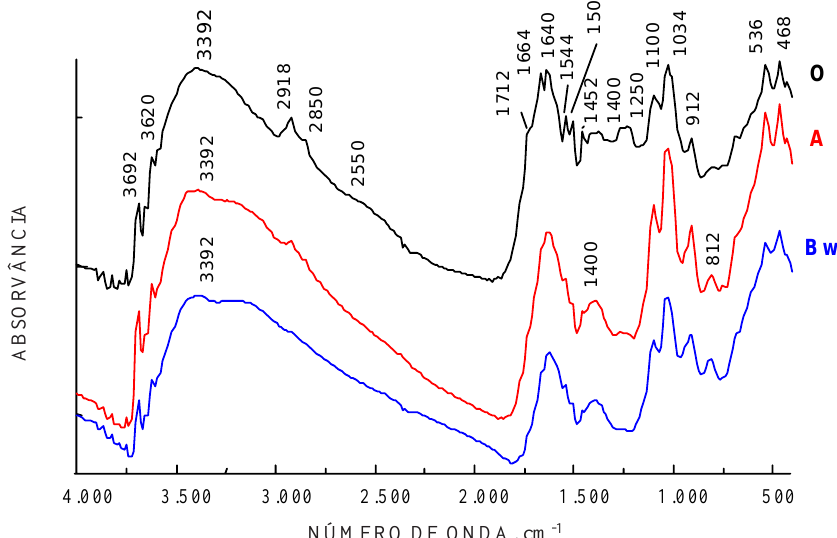
Figura 1. Espectros de absorvância no infravermelho dos ácidos húmicos não purificados, extraídos dos horizontes O, A e Bw de um Latossolo Vermelho-Amarelo (perfil 12). 2